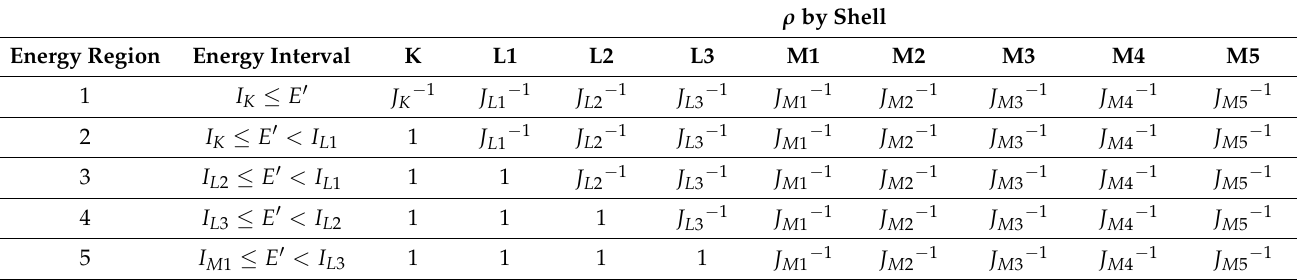
Table A3. Single-shell probabilities are computed by replacing the ρ values shown here